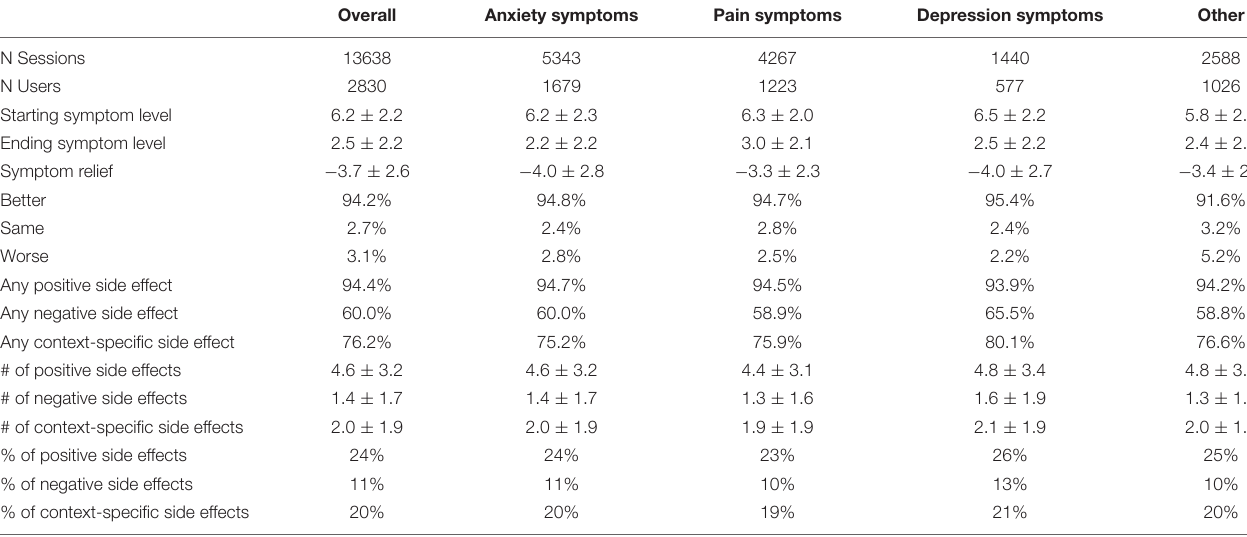
TABLE 1 | Descriptive statistics – symptom levels and experienced side effects.